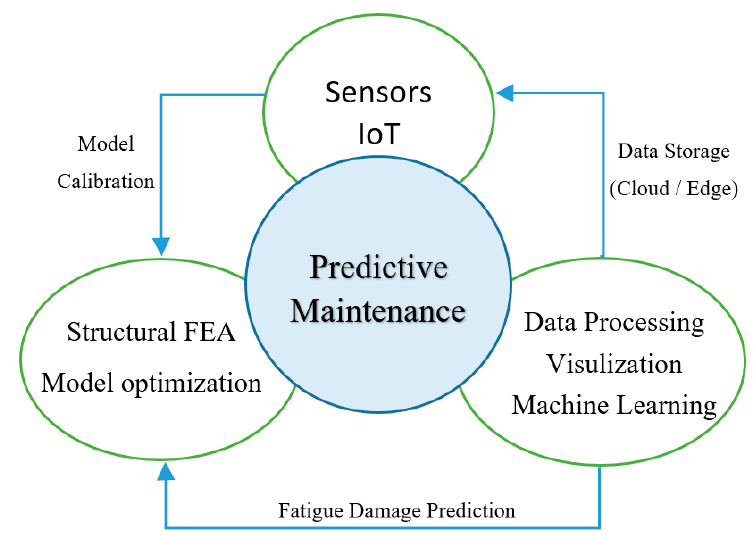
Figure 7. A digital twin system for maintenance [4].